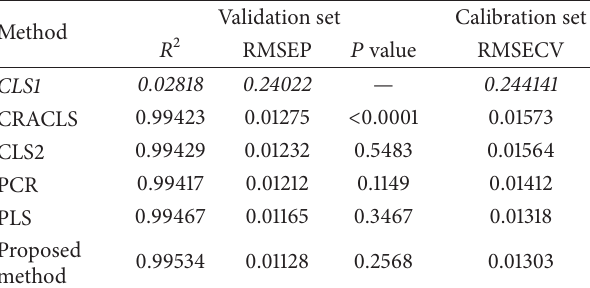
Table 1: Prediction power